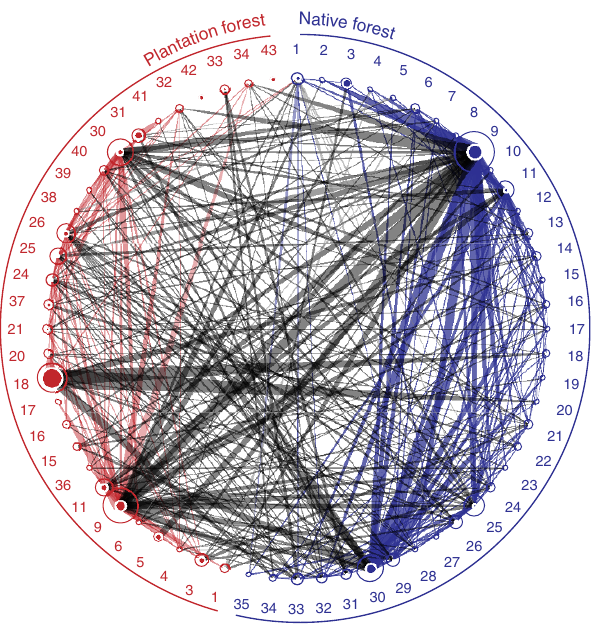
Figure 3 | Parasitoid overlap graph for the region. Data compiled from training sites (358 total parasitism events from 2725 individual hosts reared). This figure shows the potential for apparent competition between all parasitized herbivore host species in native forest (blue) and plantation forest (red). Numbers represent host species (see Fig. 2 for names), some of which are found in both habitats. Host circle size is proportional to the number of parasitoids recruiting from that host species, and circle fill represents the proportion of self-loops, that is, parasitoids attacking the same species from which they recruit. Lines between hosts represent sharing of parasitoids between those host species, with line thickness proportional to export of parasitoids 11,57 . Blue lines denote sharing of parasitoids by hosts within the native forest, red lines denote sharing of parasitoids by hosts within the plantation forest, and grey lines denote sharing of parasitoids between hosts in different habitats (the latter allowing cross-habitat apparent competition). (the d iAjB in Methods equation (3)) and the changes in abundance of hosts with which the focal host shared parasitoids. The number of species for which it was possible to calculate an expected parasitism rate at each site was far lower than the number of species collected at each site. In Fig. 5, each point represents a species within a site that was both collected and successfully reared at both time steps, and was parasitized in the first time step (see equation (3), Fig. 1i). However, the expected parasitism rates for these species within sites are based on the potential for apparent competition with every other host species that we collected in the site, whether or not it was parasitized or reared successfully, so the few data points are predicted by data from the entire network, and allowed us to test community-wide apparent competitive effects on future parasitism rates.